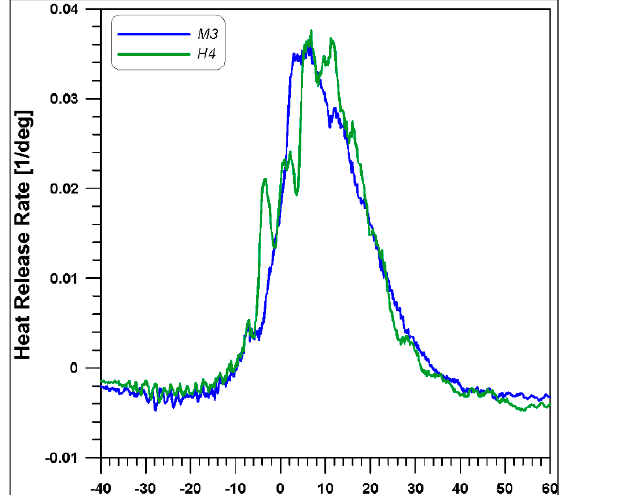
Figure 6. Accumulated heat release. Cases with hydrogen.